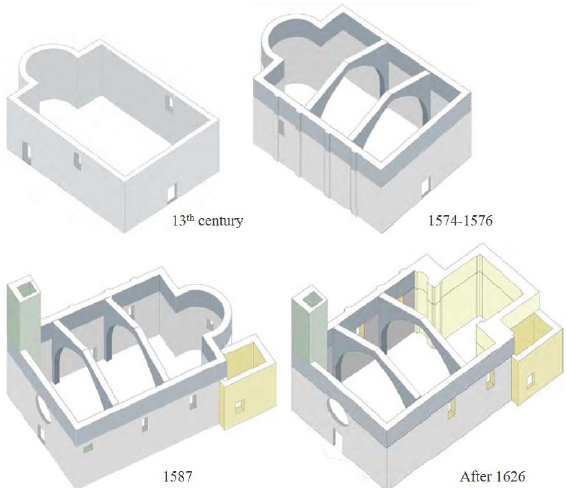
Figure 3. St. Antonio Oratory main evolution phases